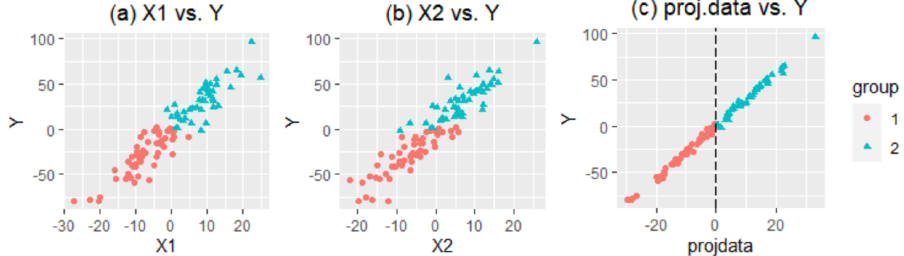
Figure 1. Toy example: 100 observations; X 1 and X 2 are highly correlated with